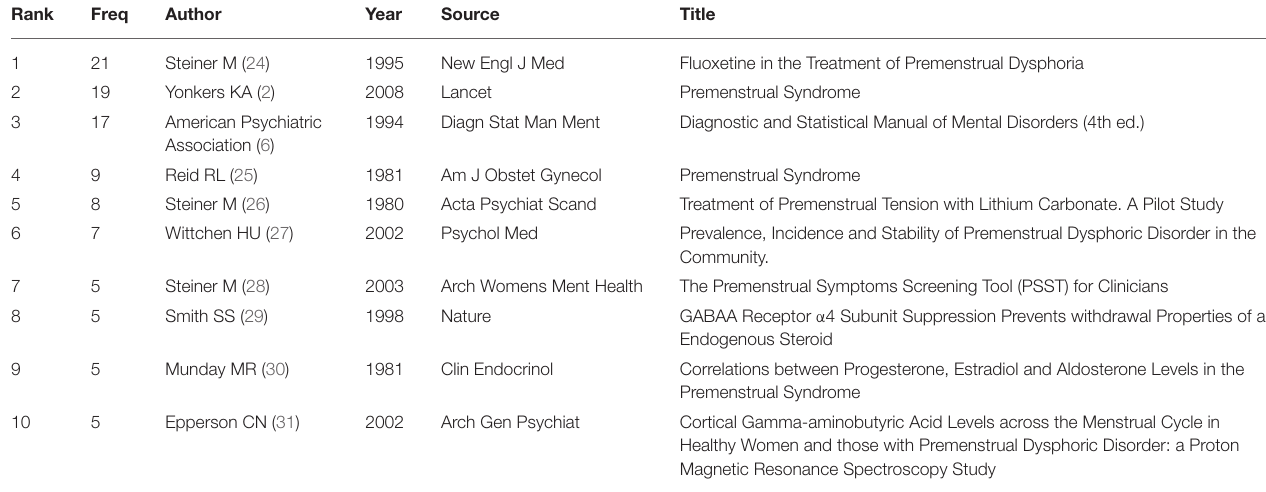
TABLE 5 | The top 10 co-cited references on PMS/PMDD during